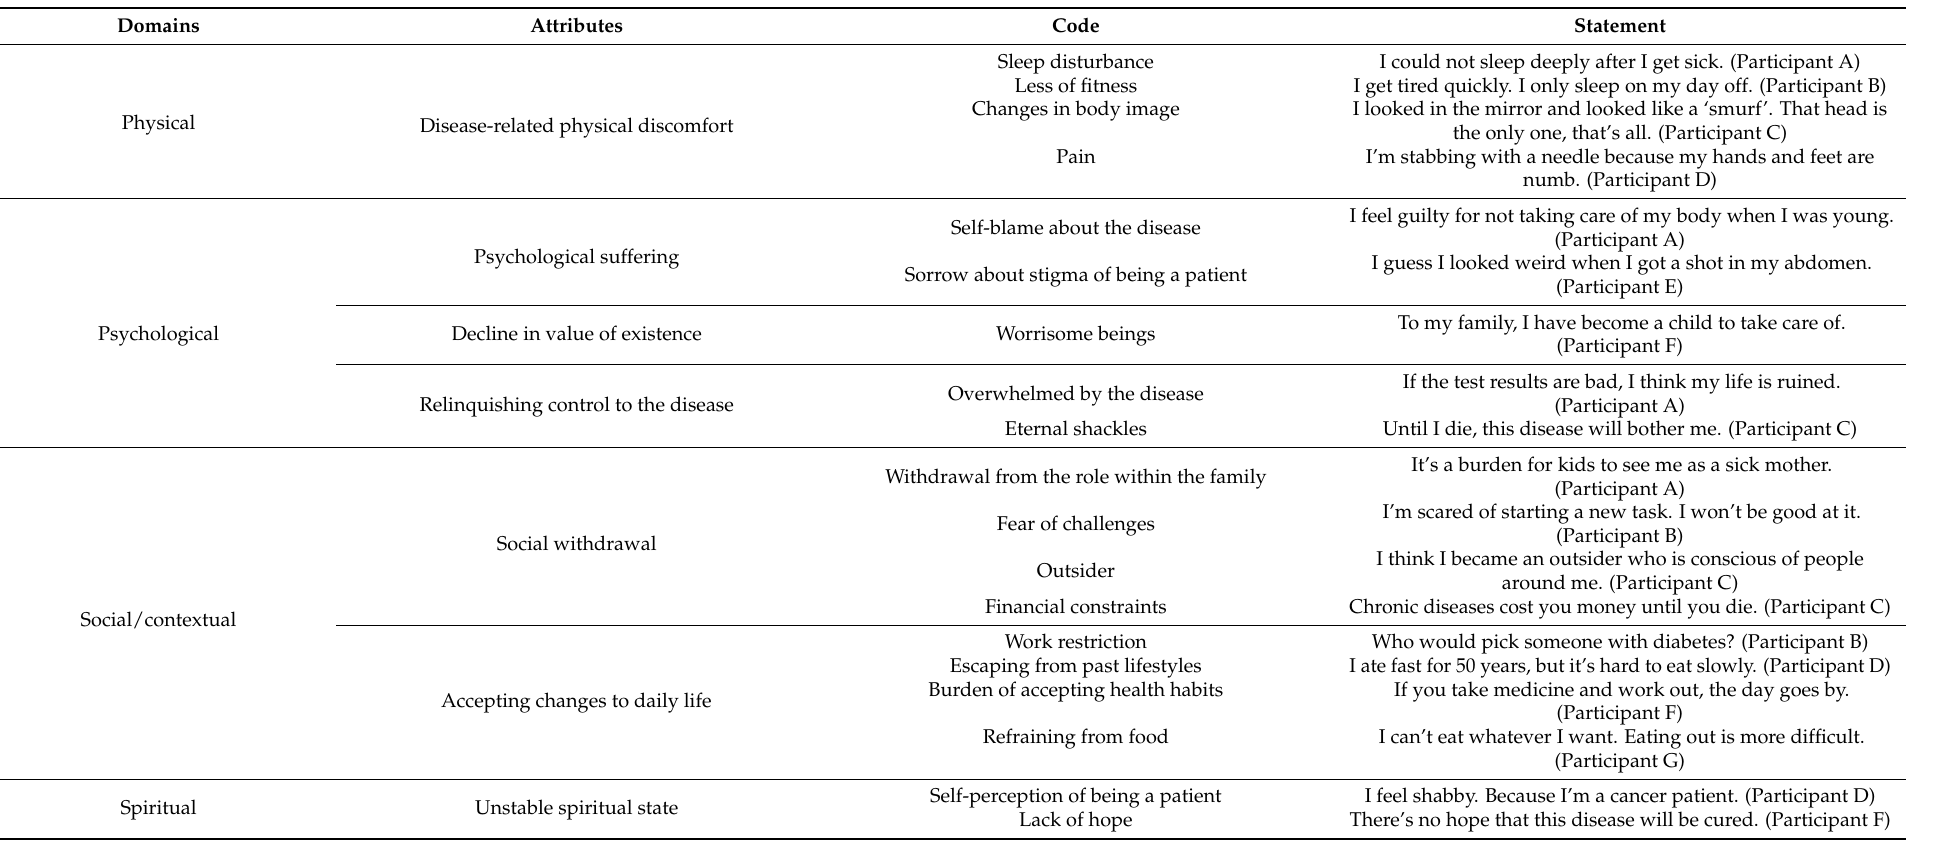
Table 3. Category and definition in the Fieldwork